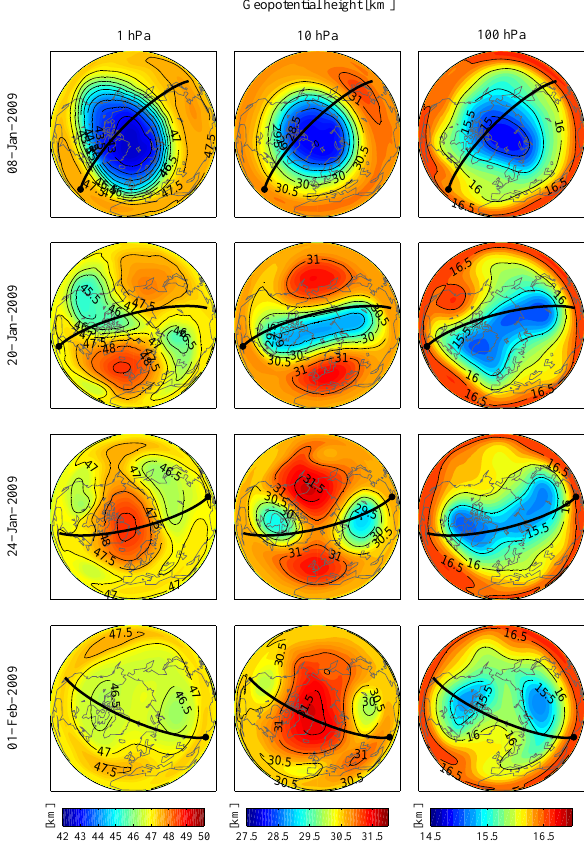
Fig. 2. NH ECMWF geopotential height field (km) at 12:00UTC on various dates in 2009 (8 January, top row; 20 January, second row; 24 January, third row; 1 February, bottom row) and various pressure levels (1hPa, left column; 10hPa, middle column; 100hPa, right column). Red indicates relatively high geopotential height values (anticyclonic circulation); blue indicates relatively low geopotential height values (cyclonic circulation). Orbits indicated are used to produce the plots comparing the analyses, measurements and PV in Figs. 4–6. The starting point of each orbit is labelled with a closed